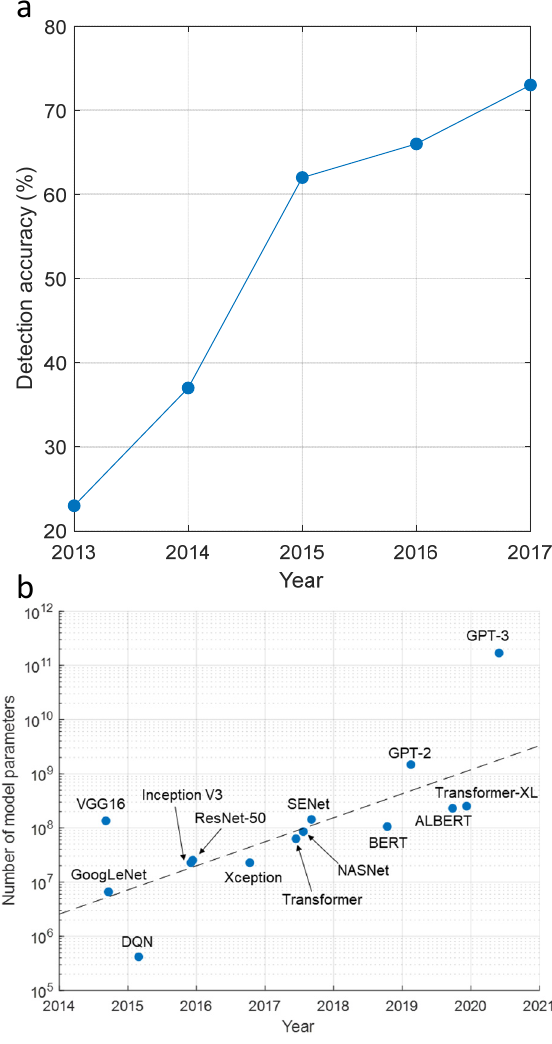
Figure 1. (a) Results from the ImageNet Large Scale Visual Recognition Challenge (ILSVRC) over a four ‐ year period. The detection accuracy increased from around 20 % to 70 % over a relatively short period of time. (b) Trends of total number of parameters included in noted ANN models (Data taken from